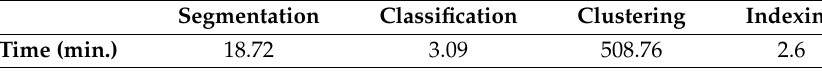
Table 7. Execution time of automated steps using a single processor.